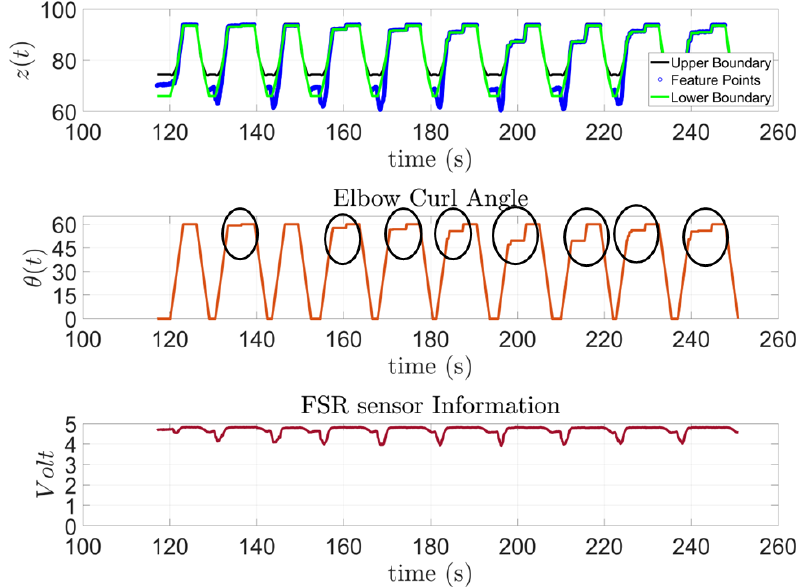
Figure 16. Subject 2: AAN through elbow flexion exercise.